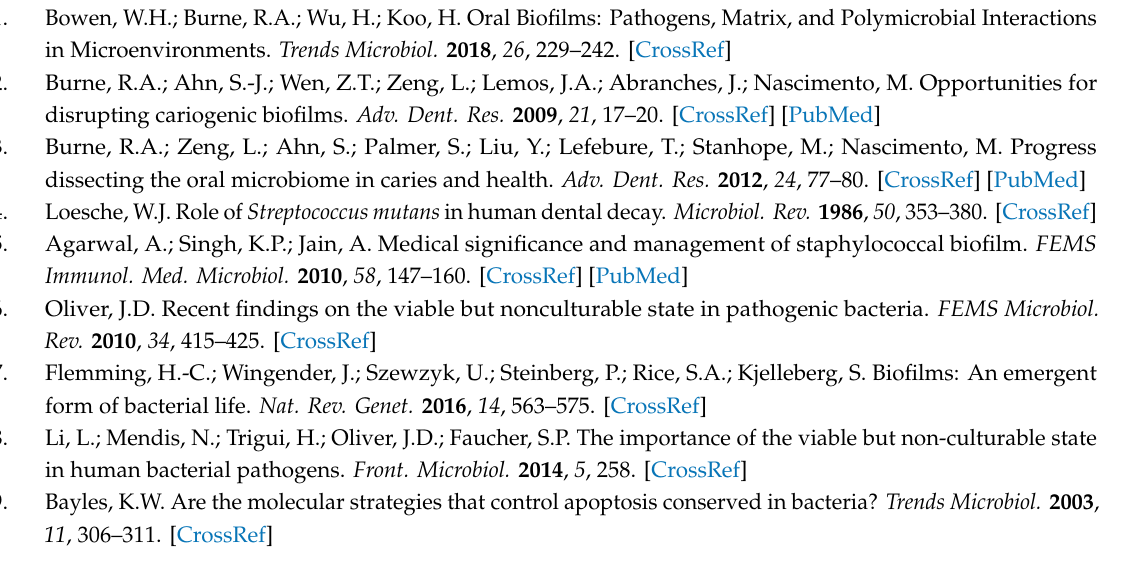
Table S1: Bacteria strains and plasmids used in this study, Figure S1: Change of P lrgA activity during growth of wild type and ∆ lrgAB mutant strains in FMC3 medium with or without 1 mM exogenous pyruvate, Figure S2: Change of P lrgA activity during growth of wild type and ∆ lrgAB mutant strains in FMC11 medium, Figure S3: Changes of P lrgA activity during growth in TV medium containing low concentrations of glucose in the ∆ lrgAB background, Figure S4: The response of P lrgA activity to 1 mM pyruvate in FMC 11 medium by disruption of the Pta-AckA pathway, Figure S5: The e ff ect of exogenously added pyruvate on the stationary phase of S. mutans UA159 wild type, ∆ pta , and ∆ ackA strains, grown in FMC11 and